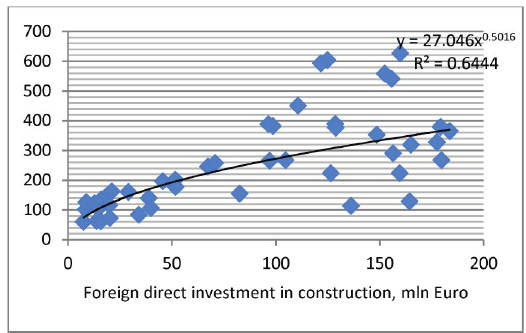
Fig. 2. The correlation between foreign direct investment in con- struction and value added by the Latvian construction sector